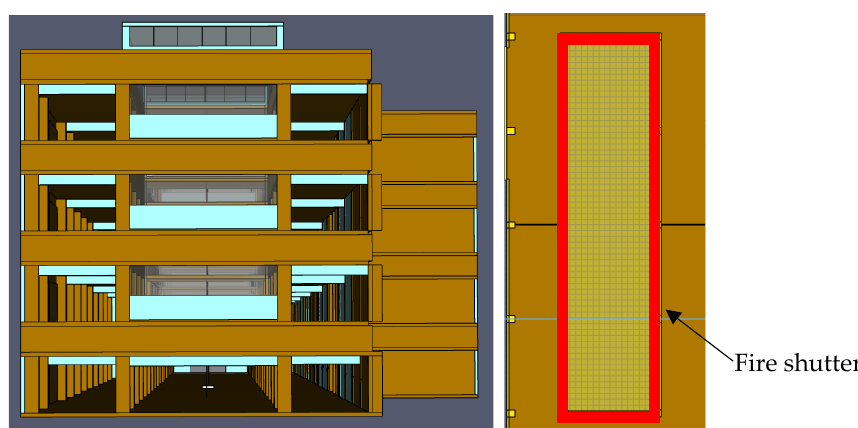
Figure 1. Schematic diagram of the numerical model of the building complex.